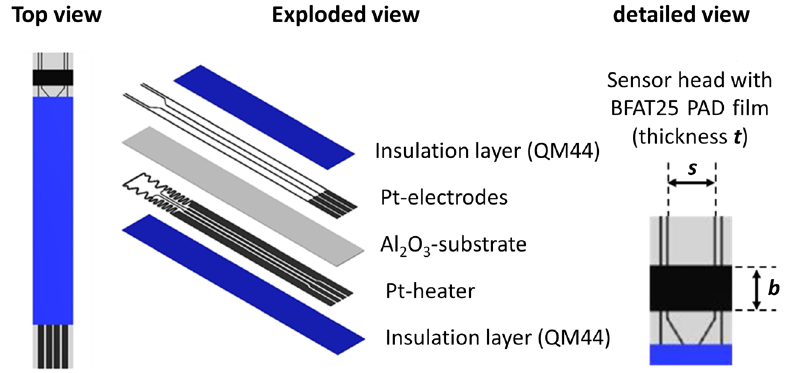
Figure 2. Scheme of the sensor elements with a BFAT25 PAD fi lm.